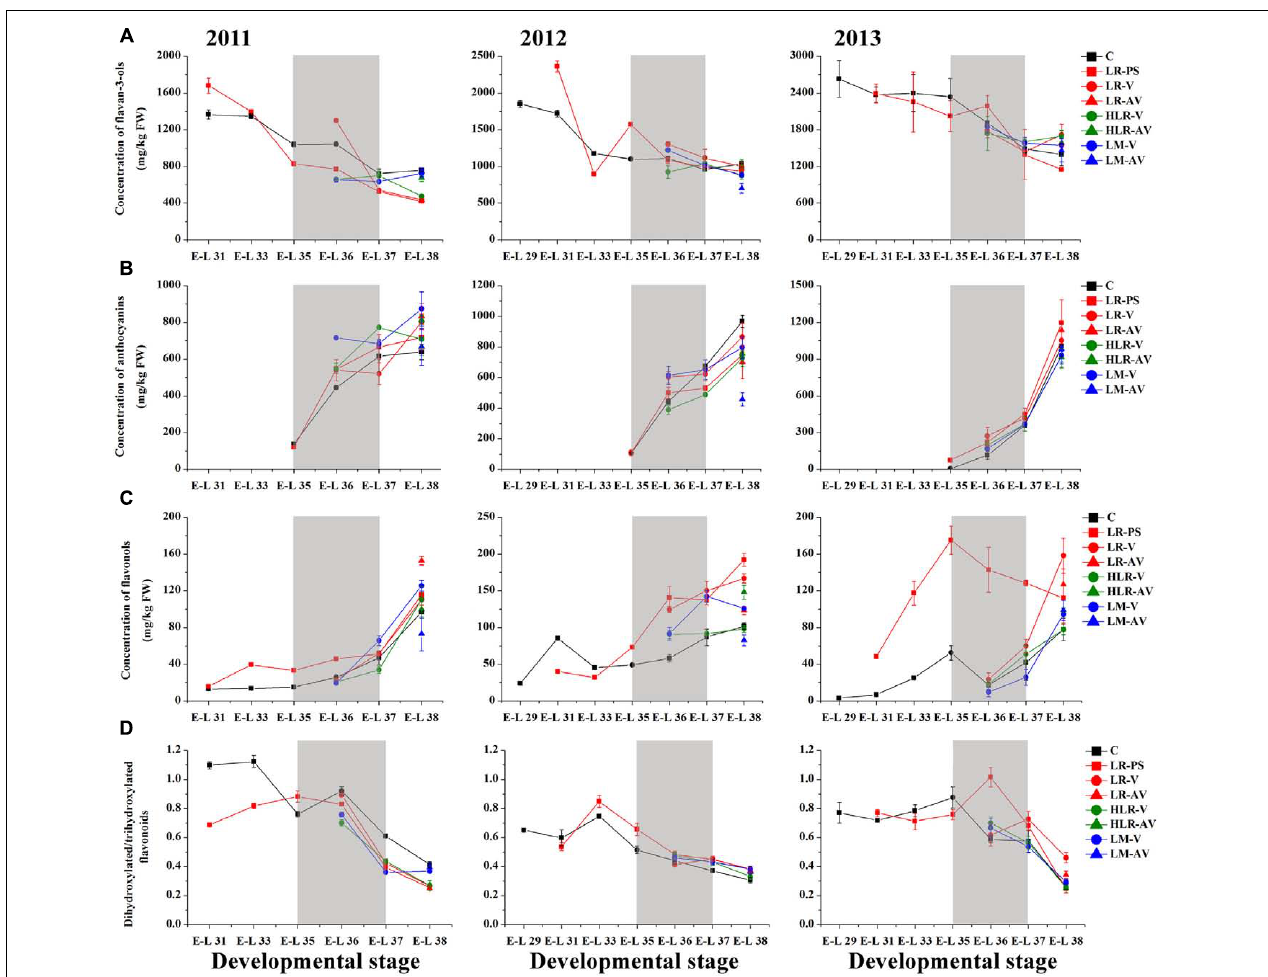
FIGURE 3 | Changes of the accumulation of (A) flavan-3-ols, (B) anthocyanins, (C) flavonols, and (D) the ratio of dihydroxylated/trihydroxylated flavonoids in different cluster sunlight exposed grape berry skins during development over three seasons. C, control group; LR-PS, leaf removal at berry pea-size; LR-V, leaf removal at véraison; LR-AV, leaf removal after véraison; HLR-V, half leaf removal at véraison; HLR-AV, half leaf removal after véraison; LM-V, leaf moving at véraison; LM-AV, leaf moving after véraison. Data are mean ± SD of three biological replicates. Light gray background represents the phenological phase of véraison from 5 to 100% of colored